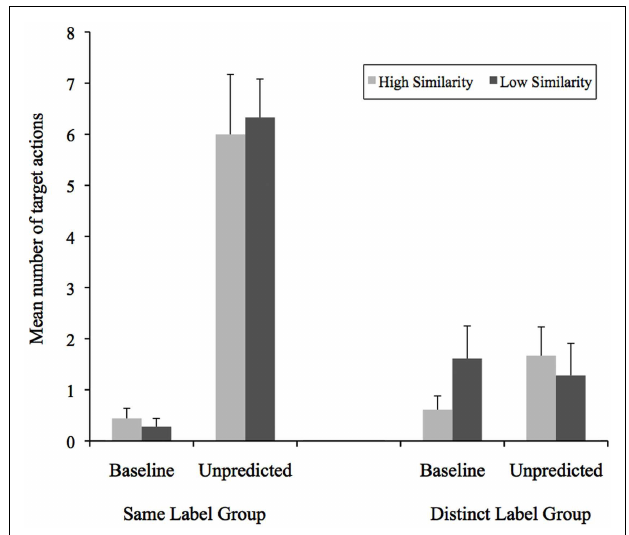
FIGURE 2 | Mean number of target actions performed on test objects as a function of label group, condition, and